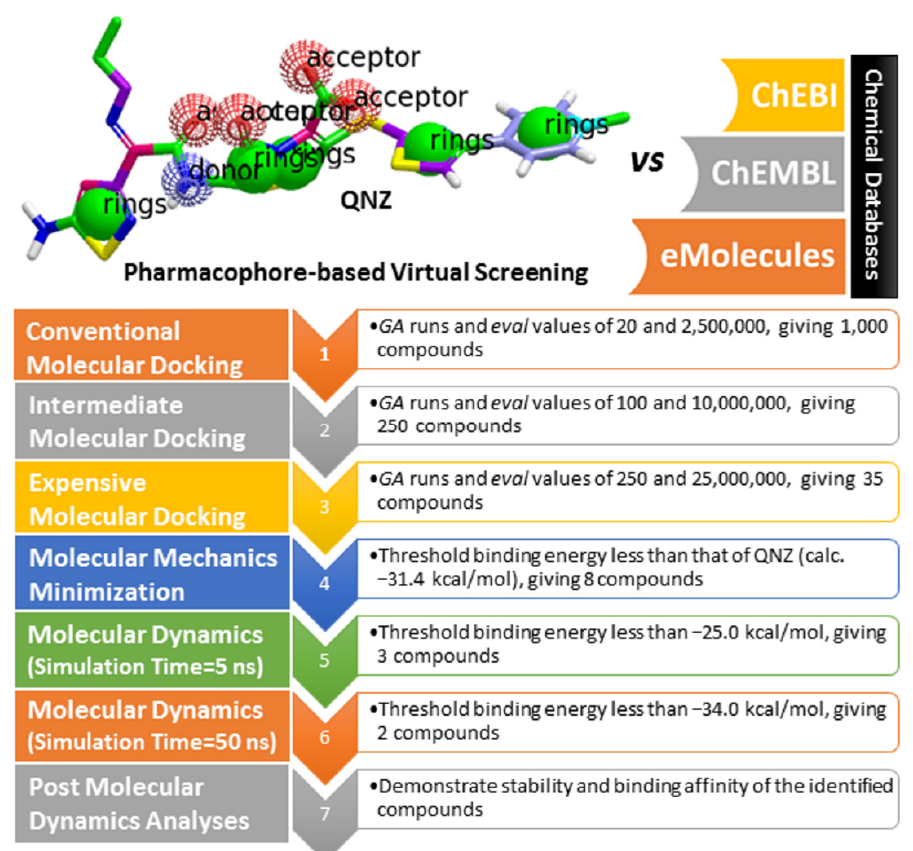
Figure 9. Schematic representation of the used in silico approaches as well as the filtration